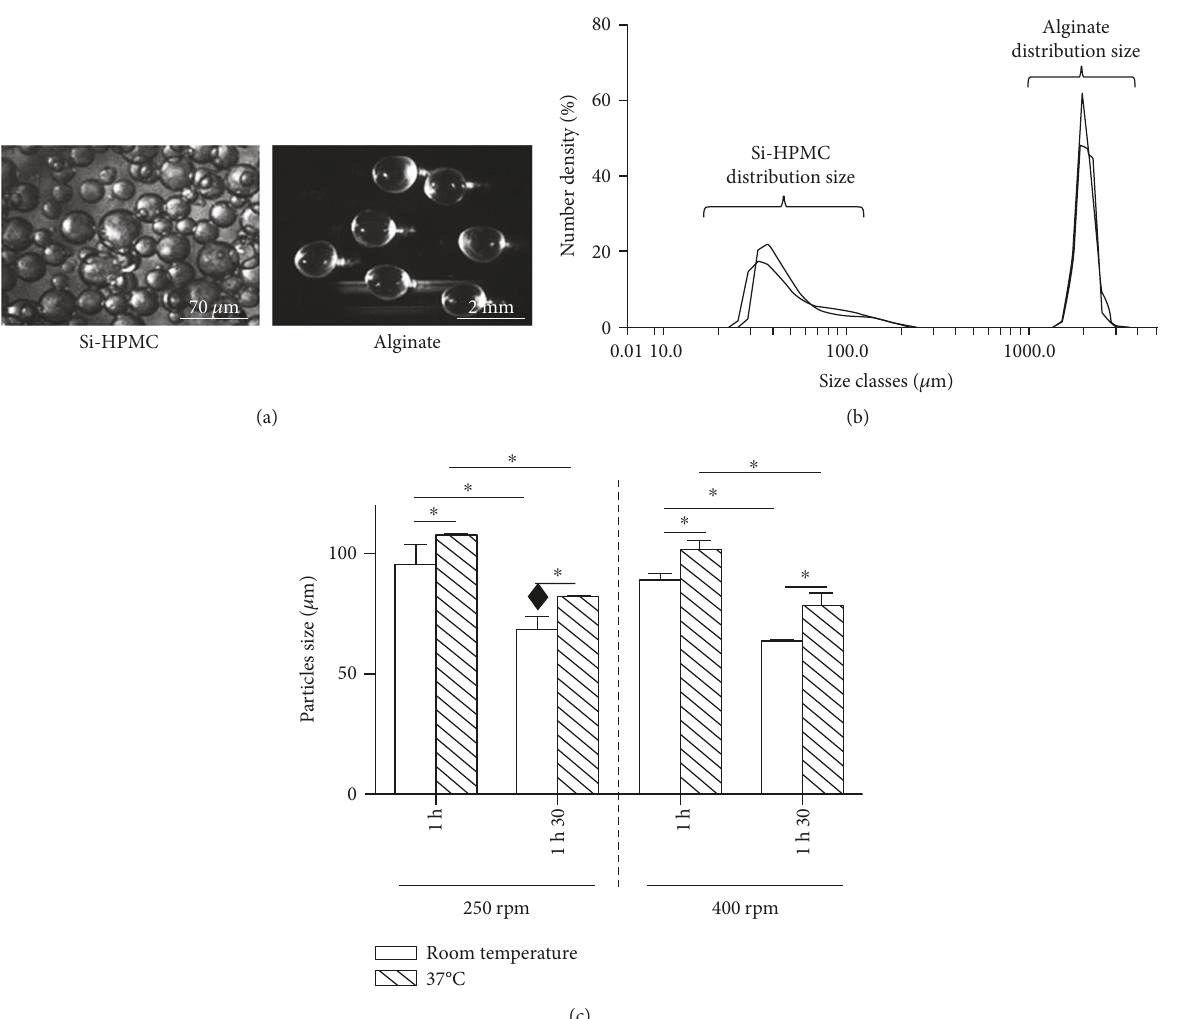
Figure 1: Particle characterization. (a) Representative observation of Si-HPMC and alginate particles obtained by oil dispersion and dripping method, respectively, and observed under light microscope. (b) Dispersity and size distribution of Si-HPMC and alginate particles investigated by laser di ff raction technique. (c) Reproducibility and e ff ect of dispersion parameters (time, temperature, and stirring speed) on Si-HPMC particle size. ♦ The operating conditions selected to generate Si-HPMC particles for the size distribution investigation (Figure 1(b)) and for the following experiments. ∗ p < 0 05 . Scale bars=70 μ m and 2mm for Si-HPMC and alginate particles,